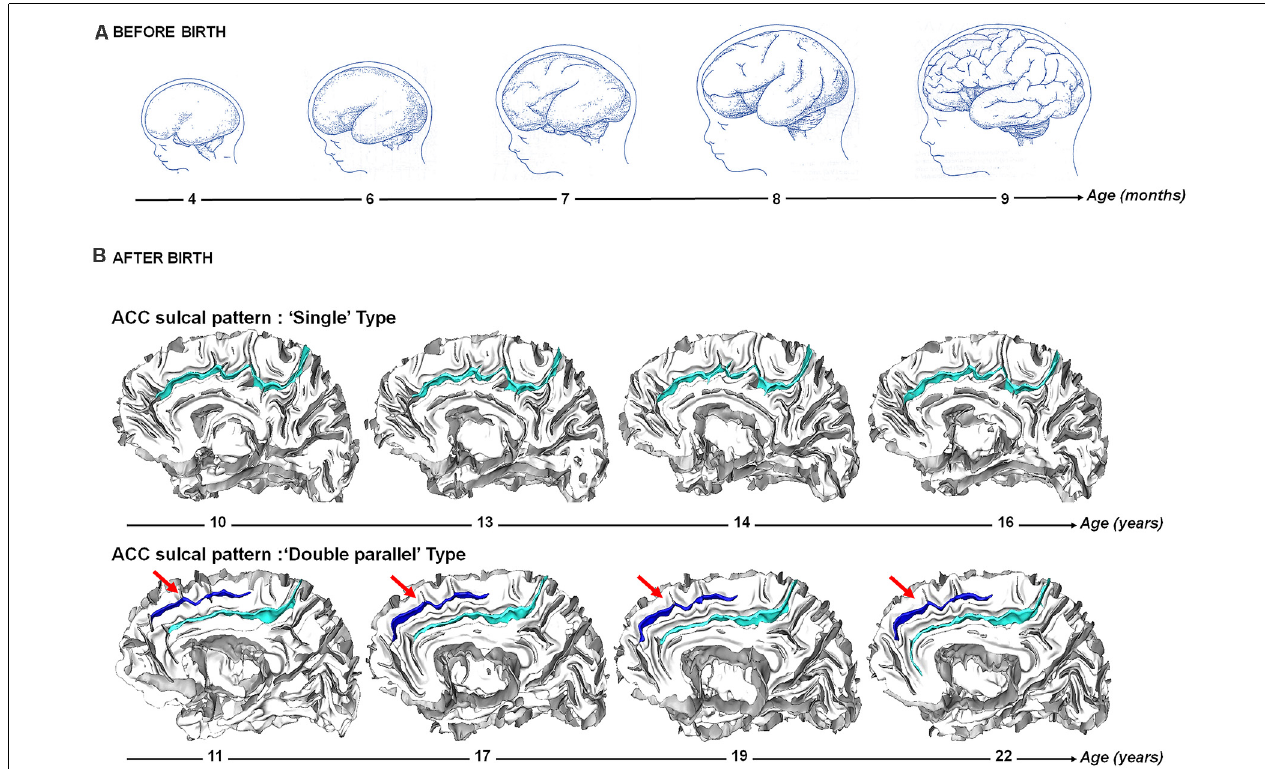
FIGURE 2 | Sulcogenesis before and after birth. (A) Before birth. Cortical folding during from 4–9 months post-conception during fetal life. Adapted from Welker (1990). (B) After birth. Longitudinal stability of the sulcal pattern of the Anterior Cingulate Cortex (ACC) pattern from 10–22 years in a participant with a “single type” ACC and in a participant with a “double parallel type” ACC. Adapted from Cachia et al.